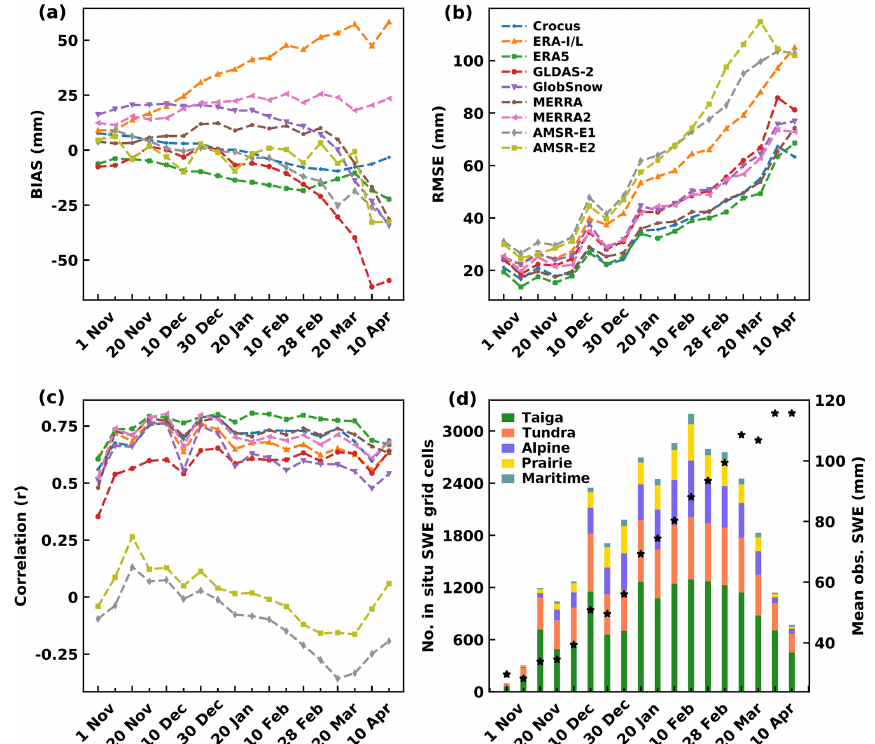
Figure 5. (a) Bias, (b) RMSE, and (c) correlation coefficient relative to the Russia snow course dataset (Sect. 2.1) for each 10d time step over the 2002–2010 period. (d) Number of grid cells with snow course observations by Sturm et al. (2010) snow class (bars, left-hand axis); mean observed SWE (stars, right-hand axis) (ERA-I/L is ERA-Interim/Land; GlobSnow is GlobSnow v2.0).